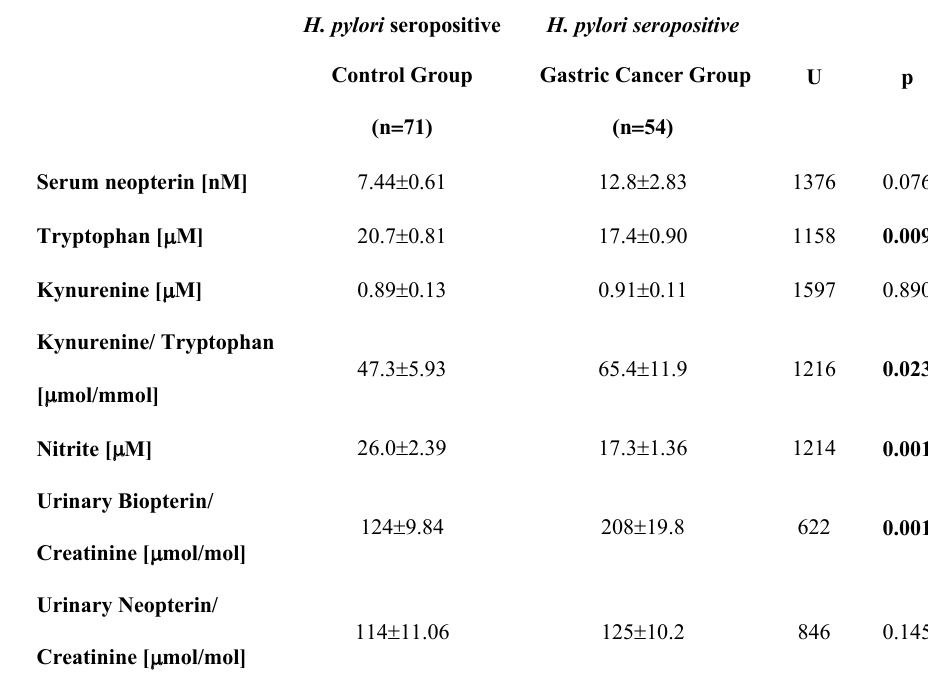
Table 3. Comparison of neopterin, tryptophan, kynurenine, nitrite, biopterin levels [mean ± SEM] of H. pylori seropositive controls and H. pylori seropositive gastric cancer